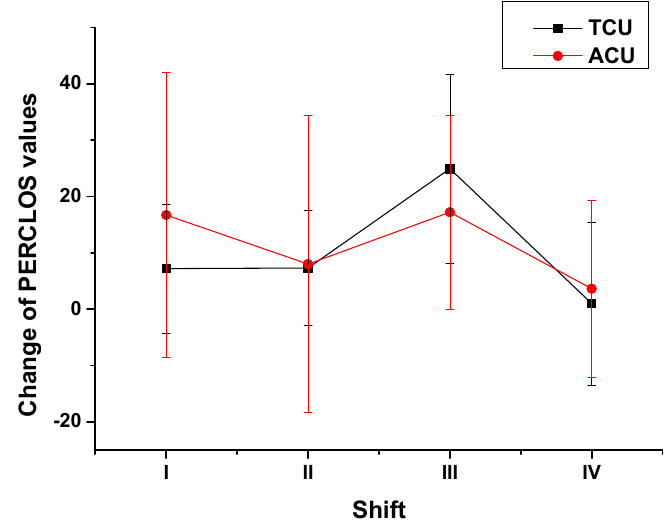
Figure 4. Changes in PERCLOS values of ATCOs by shift and work type.